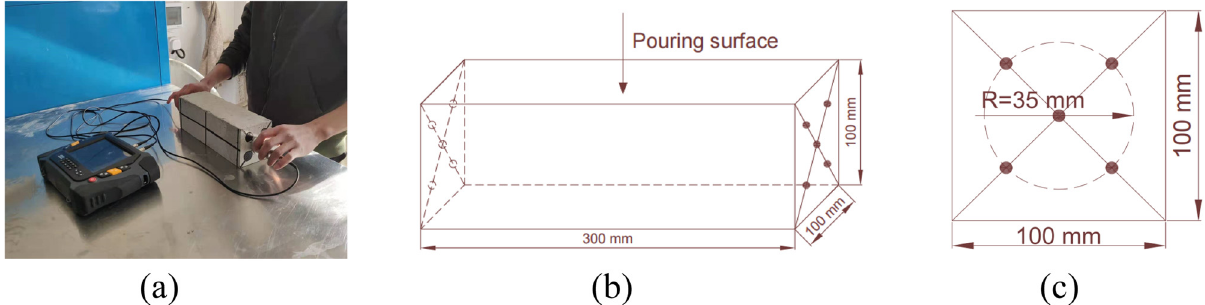
Figure 5: Ultrasonic wave velocity measurement: ( a ) actual operation diagram, ( b ) layout of measuring points, and ( c ) front view of the survey